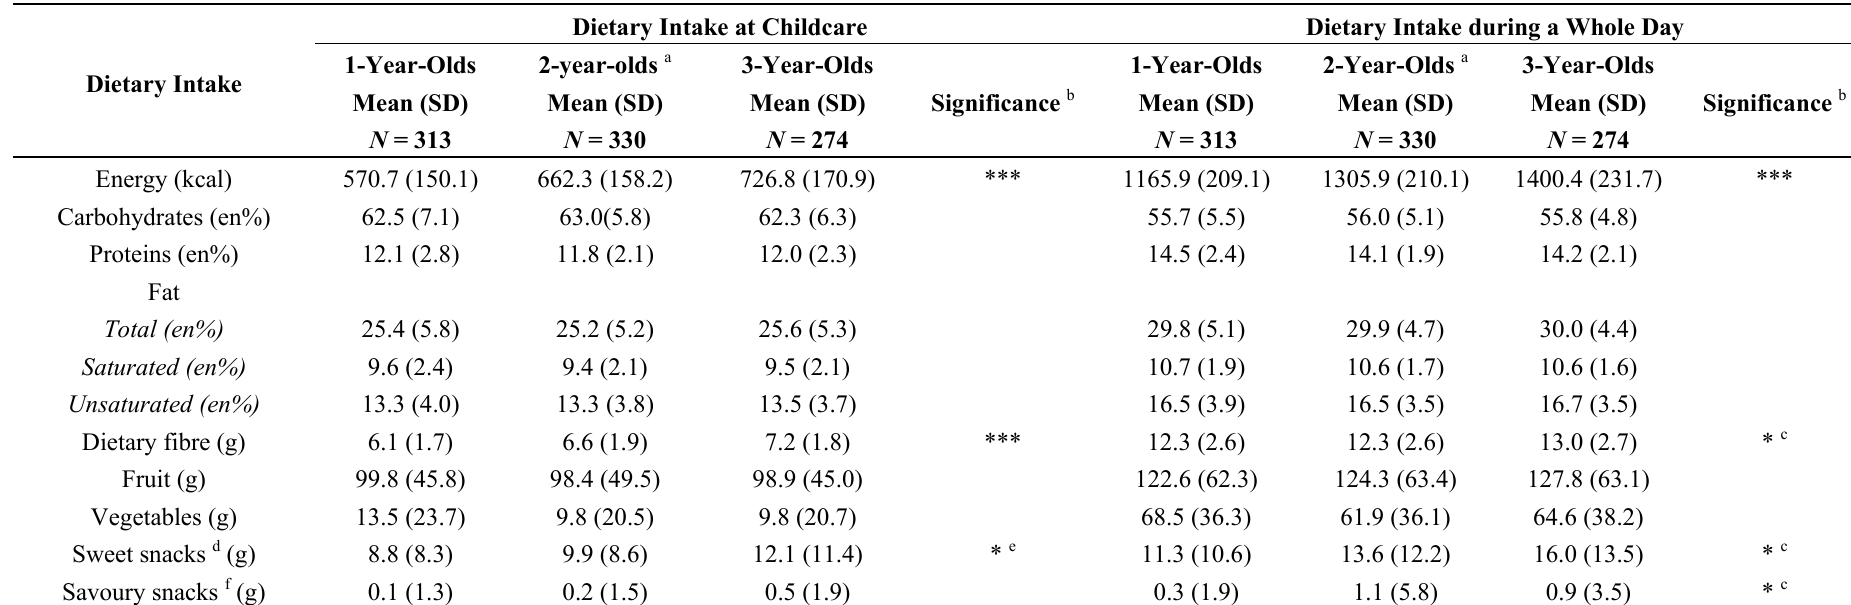
Table 4. Dietary intake differences based on